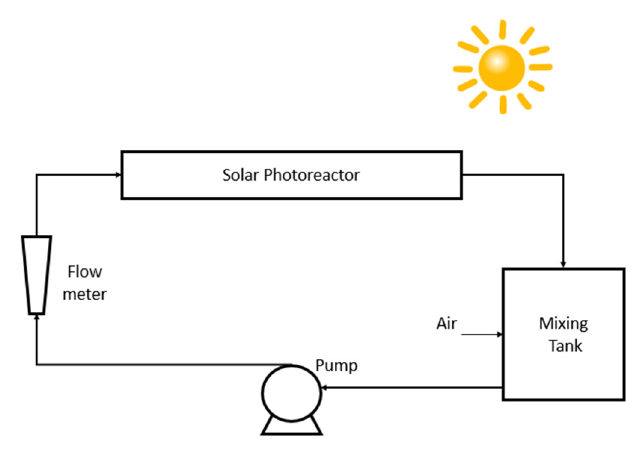
Figure 2. Scheme of a solar pilot photoreactor set-up.